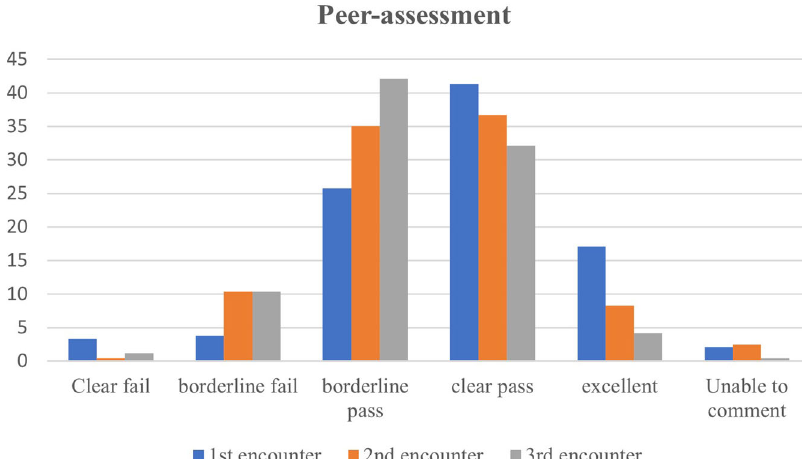
Fig. 2 Peer-assessment variation on the scale level. A bar chart showing the percentage of each of the 5-point assessment scale given by peers in the fi rst, second and third encounter.